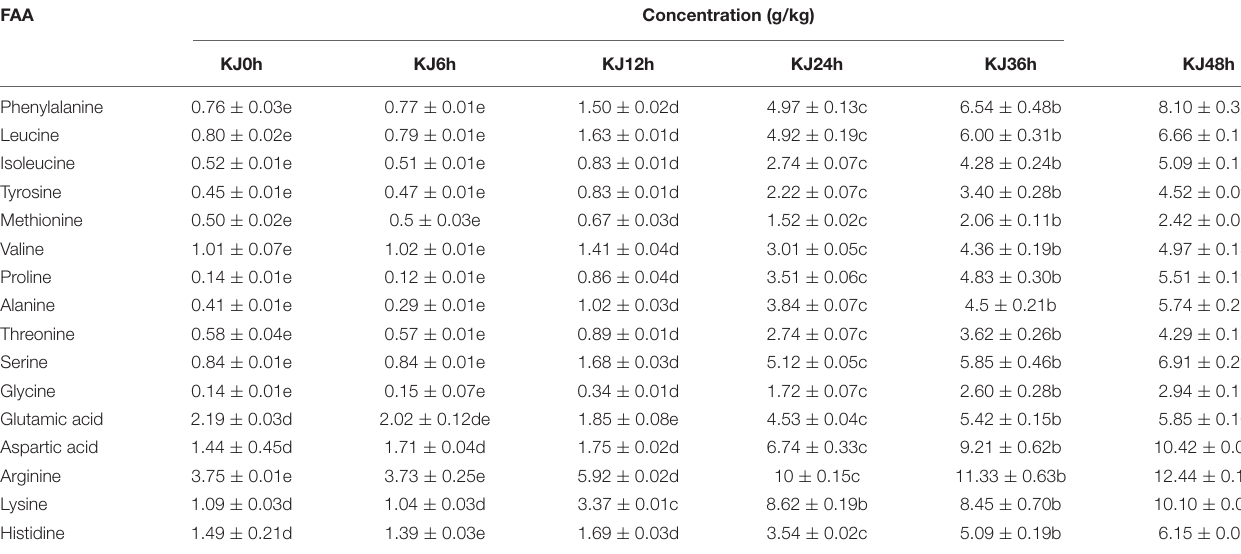
TABLE 1 | Free amino acid (FAA) profiles of samples taken from koji making fermentations at six different stages.*